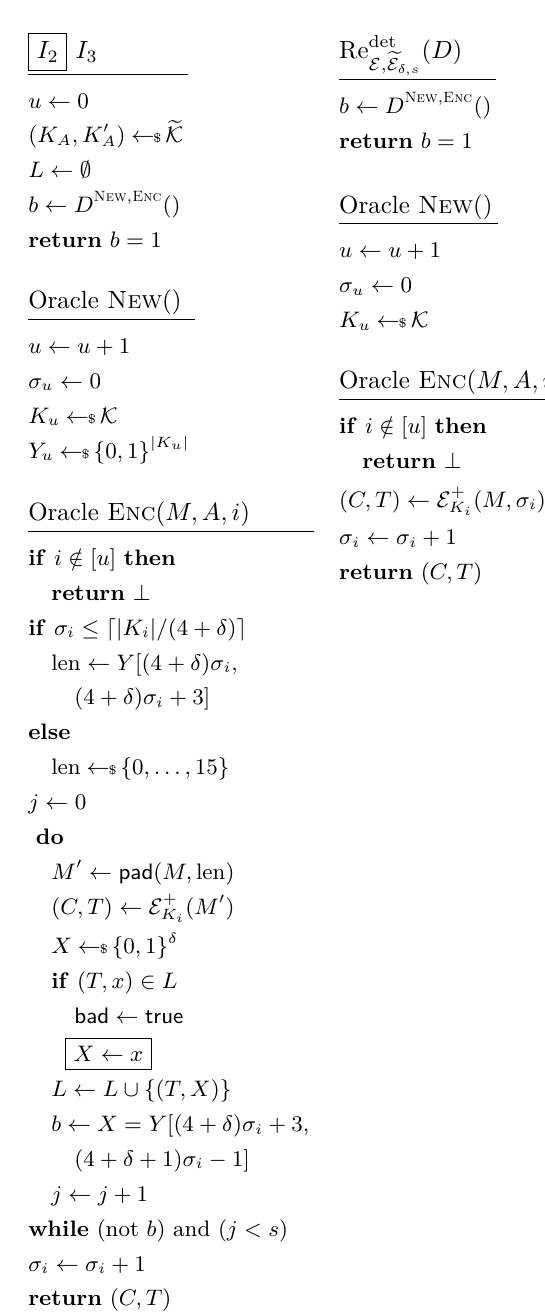
Figure 5.2: Games I 2 , I 3 , and Re det